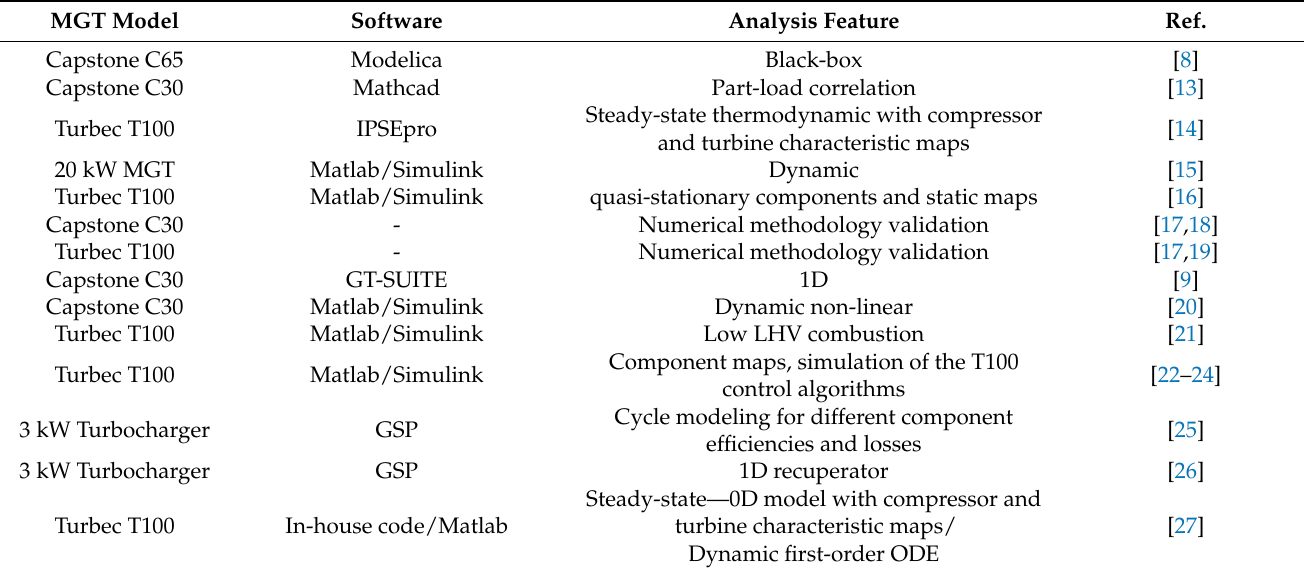
Table 1. Recuperated micro gas turbine